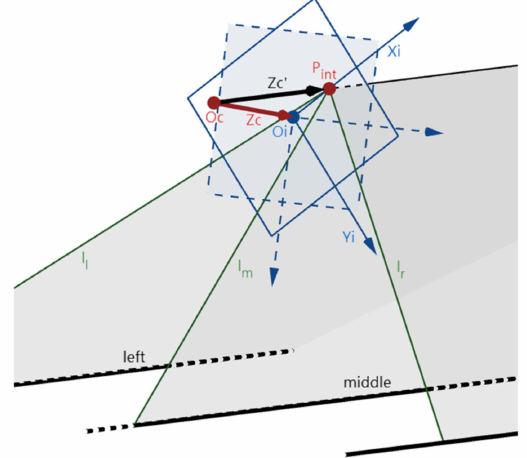
Figure 4. The position change of the IMG in step 2.1. (Xc-, Xc’-, Yc-, and Yc’-axes are omitted).